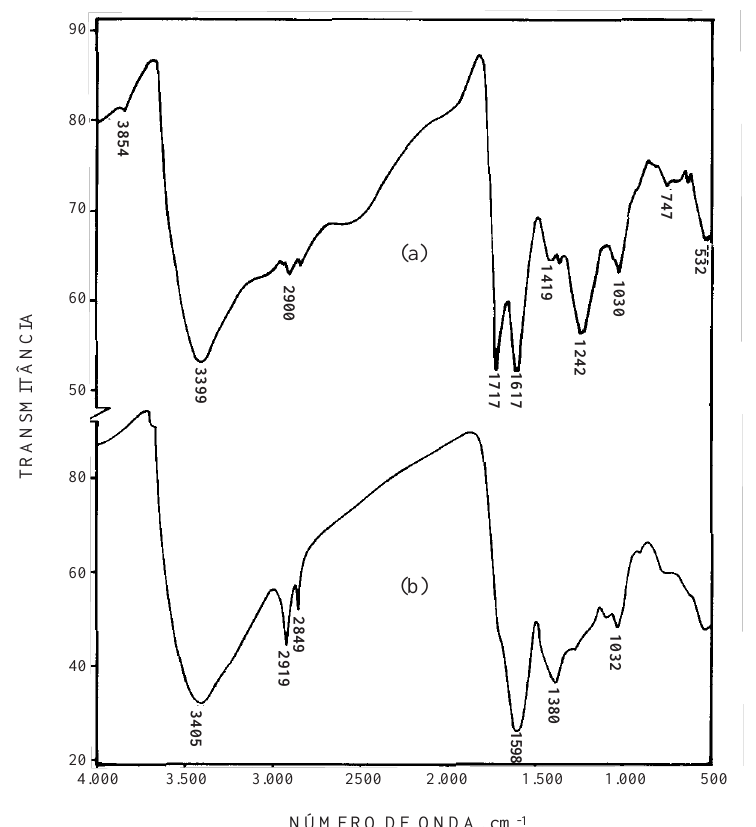
NÚMERO DE ONDA, cm Figura 1. Espectros de infravermelho de AH-Espodossolo (a) e AH-comercial (b).